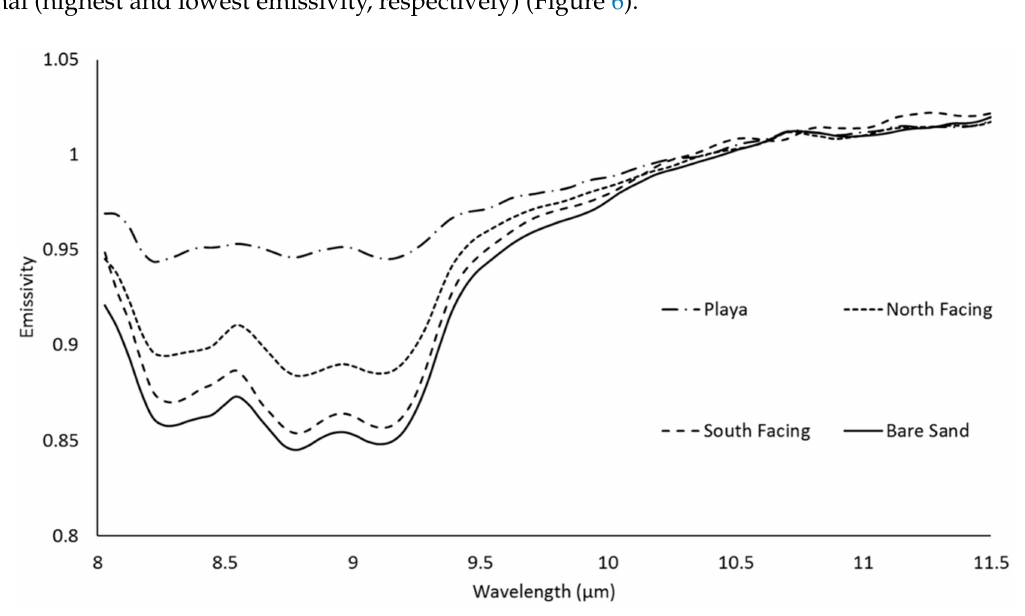
Figure 6. Pixel emissivity spectra of the four major types of samples taken from the field for analysis: A playa surface with the highest overall emissivity followed by a north-facing biological soil crust (BSC), a south-facing BSC, and bare sand showing the strongest quartz